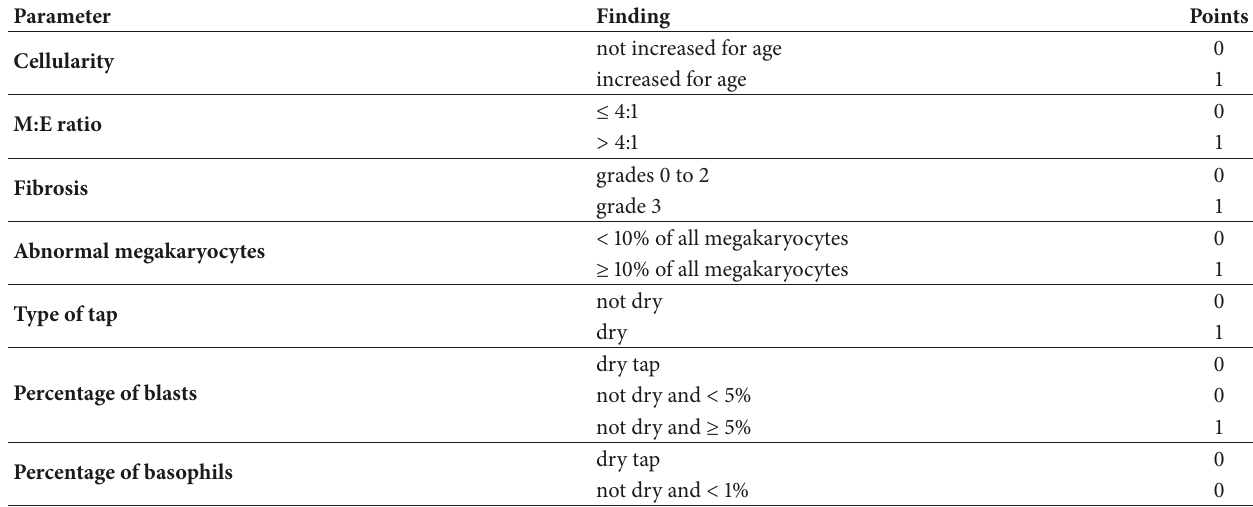
Table 1: Criteria for assessment of morphological